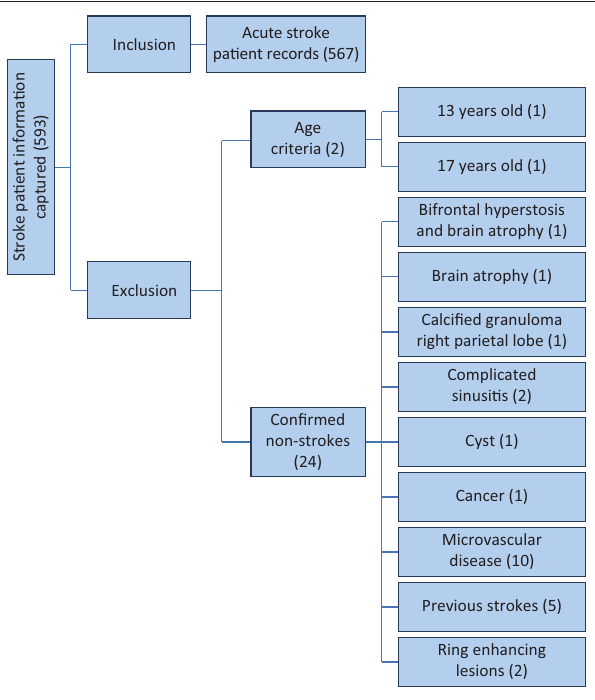
FIGURE 1: Flow diagram of included and excluded patient records